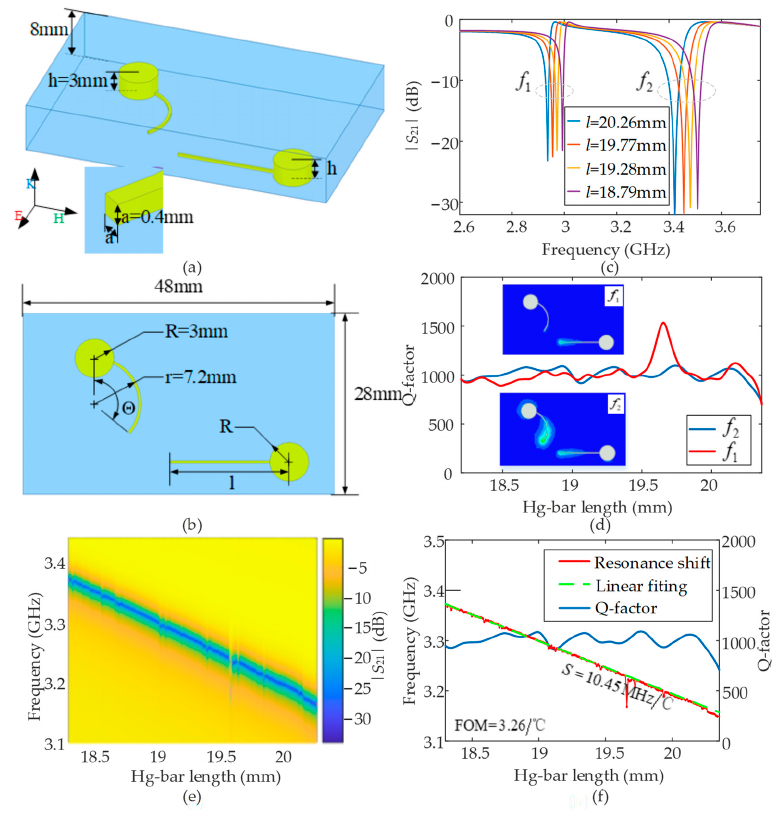
Figure 3. ( a , b ) The 3D and 2D views of the modified Hg-EIT-like metamaterial unit with parameter definitions; ( c ) the transmission curves under different Hg bar lengths obtained by numerical simulations in the period boundary condition; and ( d – f ) the simulated and calculated transmission 2D spectrum, the Q-factor, and the sensitivity results. The insets of panel ( d ) are the electric field distributions at the two resonance frequencies.